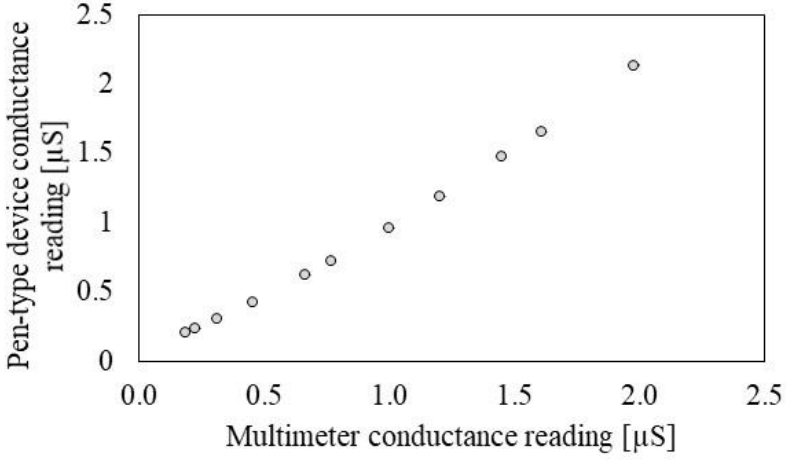
Figure 4. Conductance measurement performance of the present pen-type device for the reference resisters.